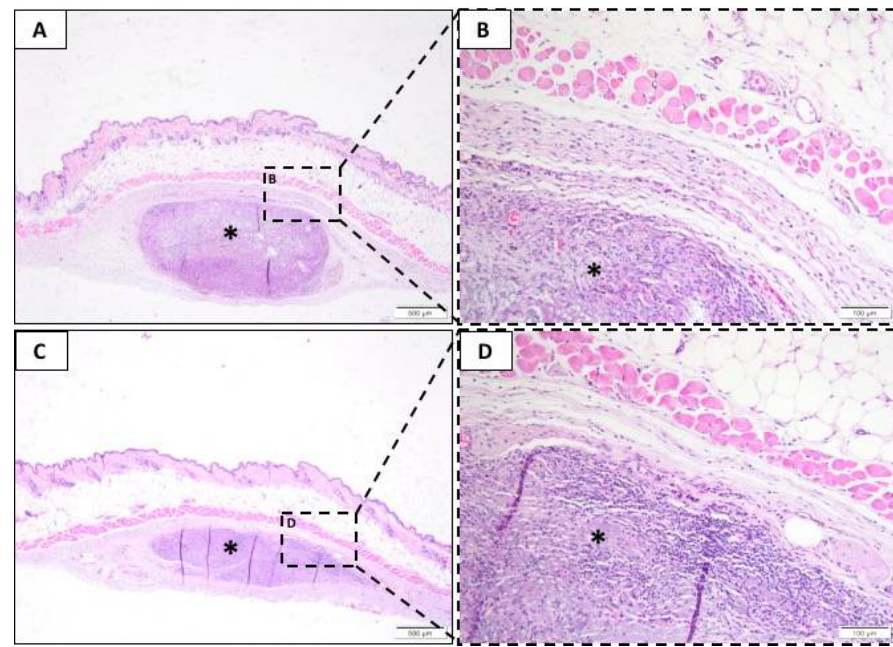
Figure 4. Representative photomicrographs of subcutaneous injury after 63 days. Histological section stained with hematoxylin/eosin from the incision region in the BG groups ( A , B ) and LT groups ( C , D ). The area occupied by the membrane is indicated by an asterisk (*). ( A , C ) 40× magnification, scale bar: 500 µm; ( B , D ) 200× magnification, scale bar: 100 µm.